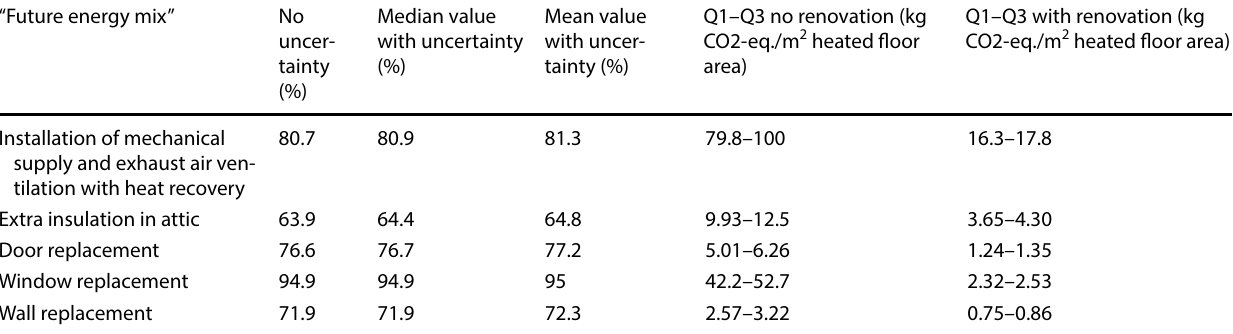
Table 6 First quartile to the 3rd quartile climate change poten- tial for all renovation measures using the “Future energy mix”. The percentage differences in the climate change potential after carry- “Future energy